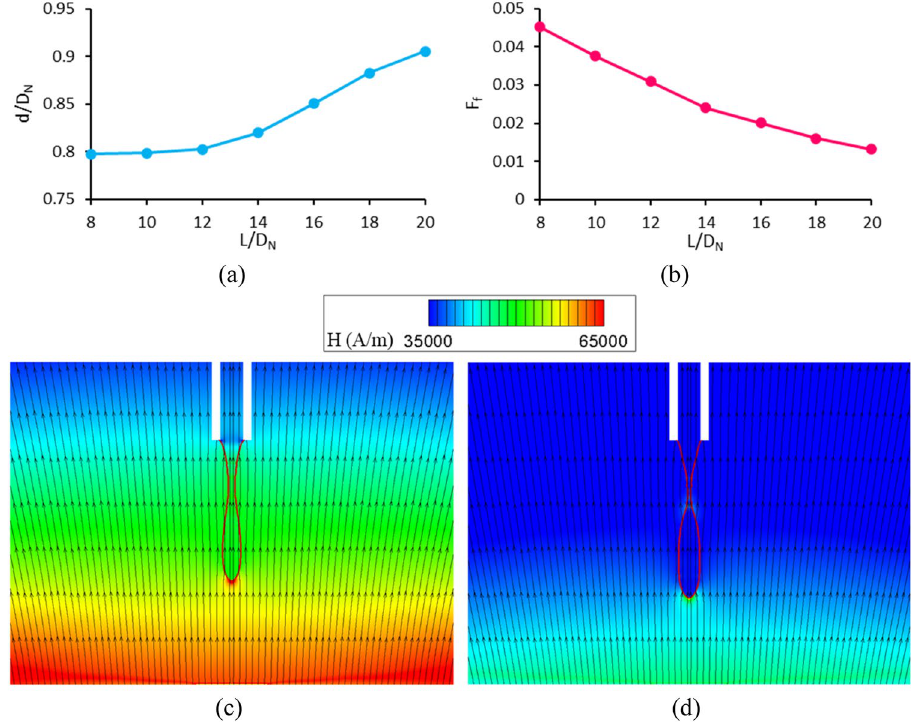
Figure 16. Effect of the ratio of the distance between the nozzle and the center of the top surface of the coil to the outer nozzle diameter on the ( a ) the dimensionless diameter and ( b ) the dimensionless formation frequency. ( c ) Magnetic field strength contours and magnetic lines for ( a ) L D